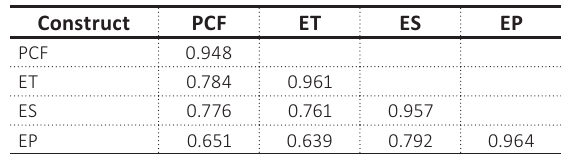
Table 3. Discriminant validity